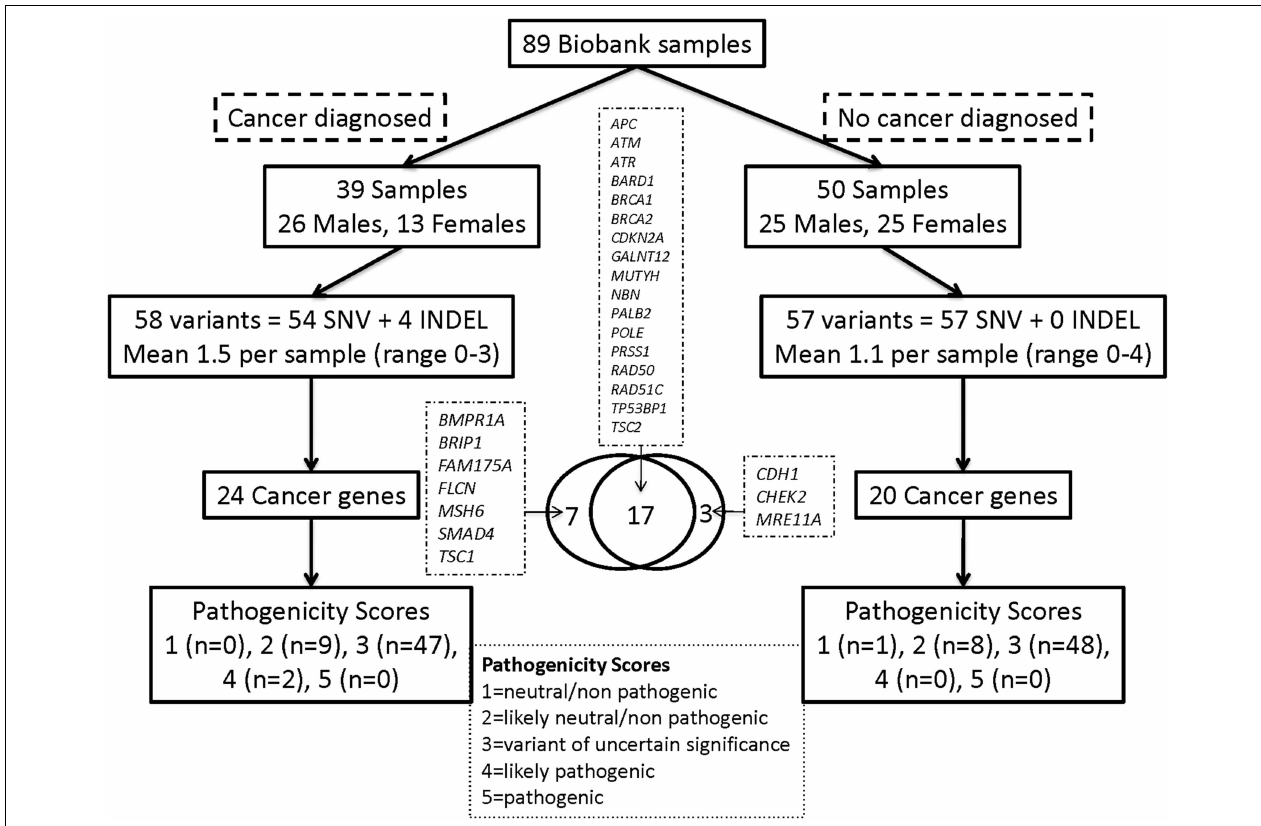
FIGURE 2 | Distribution of Tier-1/Tier-2 variants by cancer history and gender for the cancer predisposition genes. Overall, 39 (44%) of the 89 participants had a diagnosis of cancer: 23 (59%) of these from the 39 group-1 participants and 16 (32%) of the 50 group-2